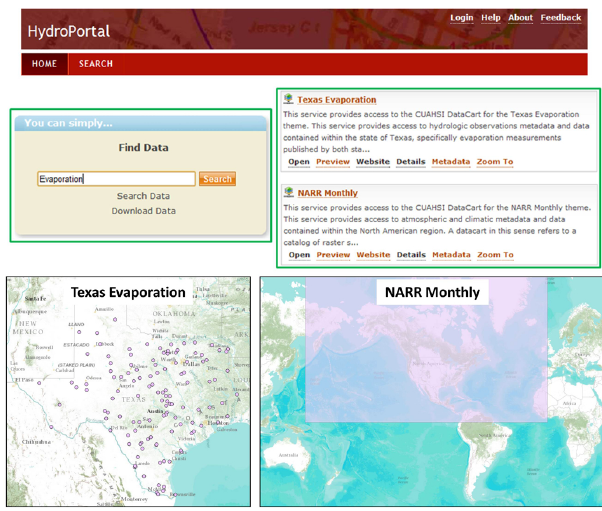
Fig. 11. List of metadata services, implemented as WFS, returned by experimental CUAHSI-HIS HydroPortal (keyword “Evapora- tion” was used as the semantic